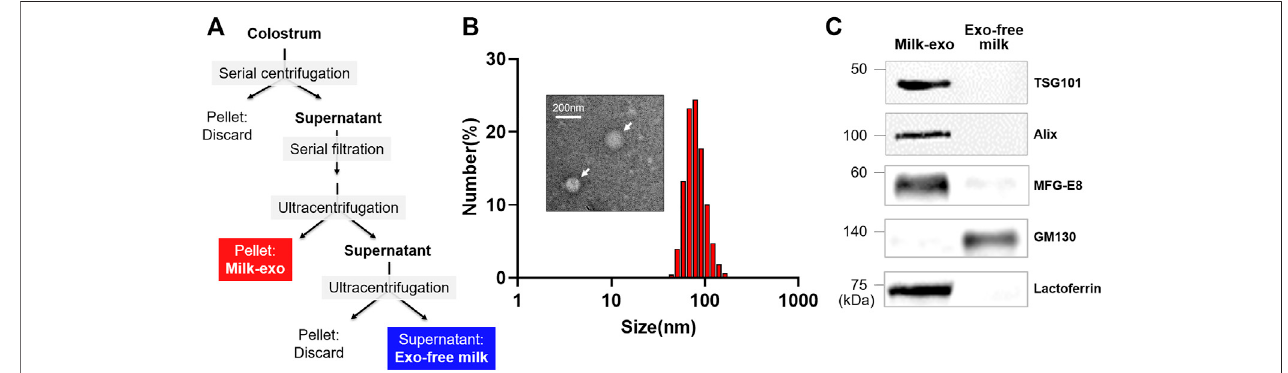
FIGURE2| Preparationandcharacterizationofcolostrum-derivedexosome(Milk-exo). (A) SchemeofthepreparationprocedureofMilk-exoandExo-freemilk. (B) SizedistributiondiagramandrepresentativeTEMimageofMilk-exo. (C) Westernblotanalysisofcommonexosomemarkers(Tsg101andAlix)andmilkspeci fi cproteins (MFG-E8 and lactoferrin). GM130 was used as a negative control.